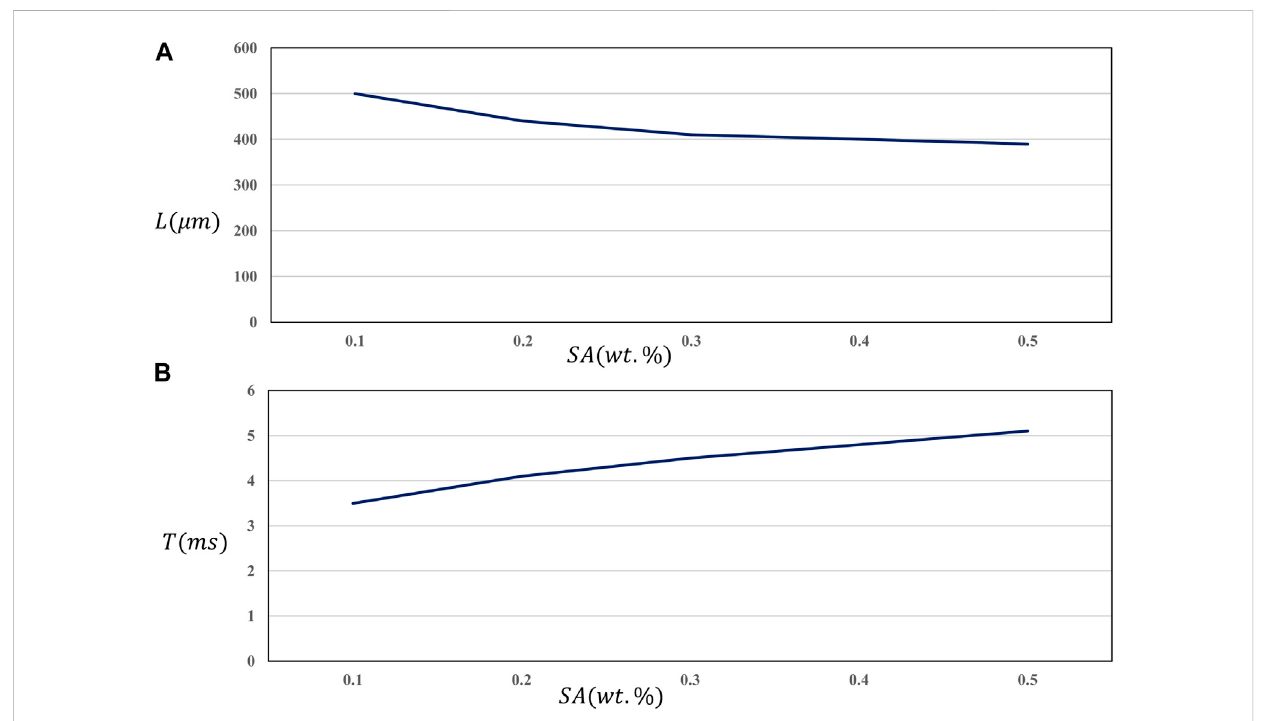
FIGURE 7 Characteristic length of slug under different viscosity (A) ; Generation cycle under different viscosity (B)